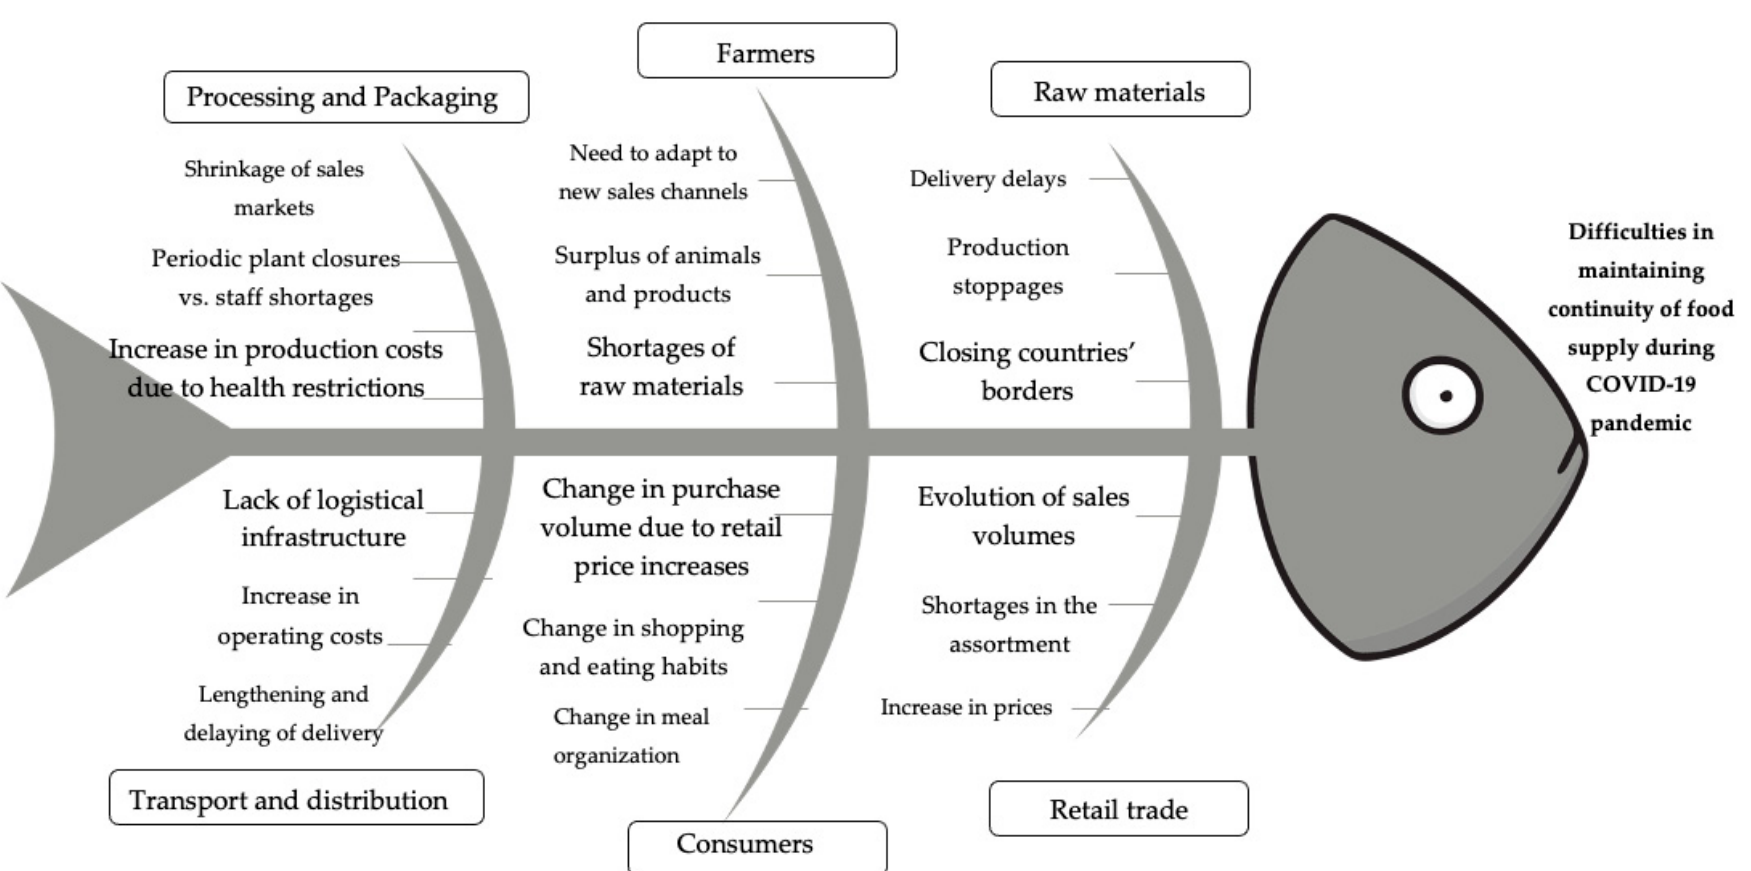
Figure 2. Ishikawa’s fishbone diagram on main problems in maintaining resilience of food supply chain on the meat market during COVID-19 pandemic.